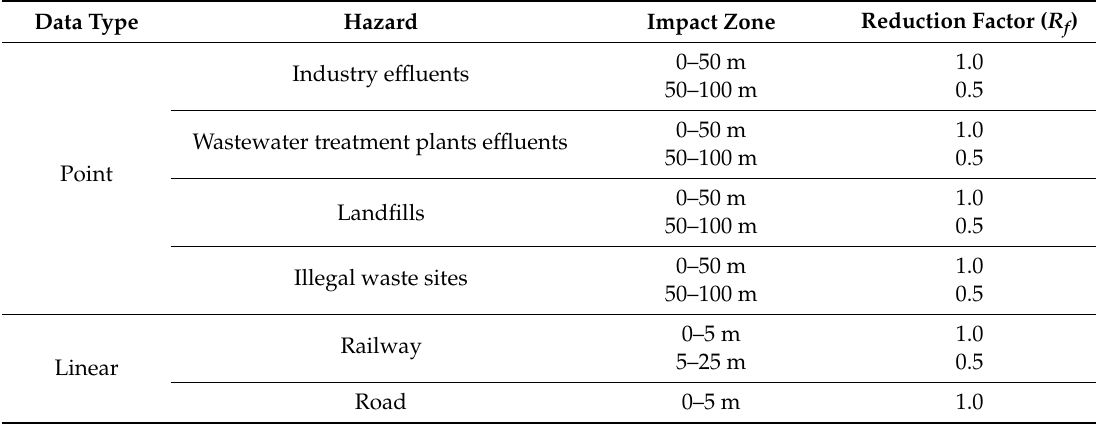
Table 3. Hazards impact zones, categorized according to the data type.